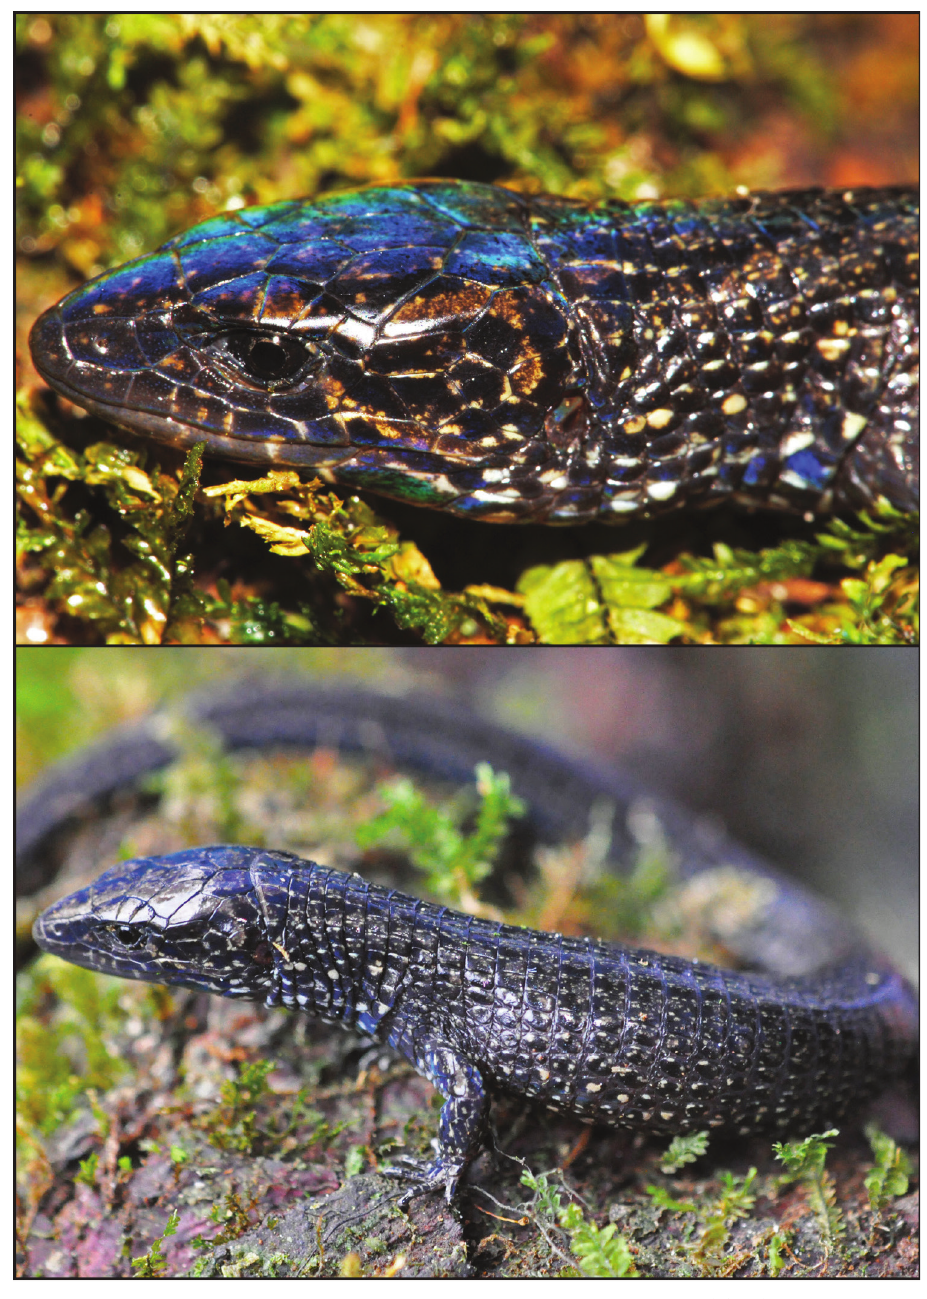
Figure 2. Oreosaurus serranus sp. n. (paratype, ROM 53609 [68.6 mm SVL]) in life. Photos: S.M.S (top) and Jhon Jairo Ospina-Sarria